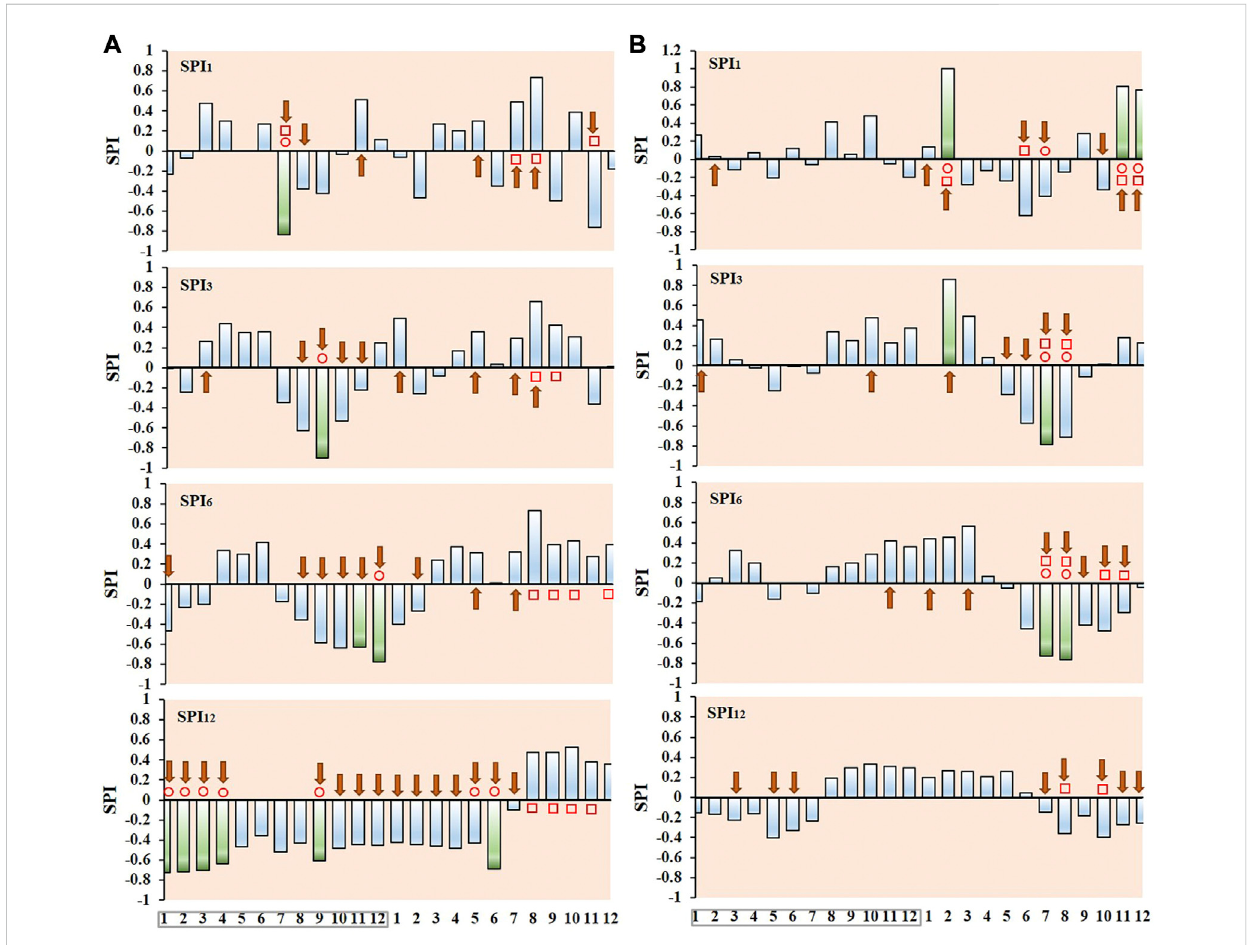
FIGURE 7 Mean SPI values at different timescales from the SPI series in the Weihe River basin. (A) El Niño and (B) La Niña years (boxed)and the year after these events. Green columns, signi fi cant differences in SPI values between El Niño/La Niña and the remaining years; blue columns, no signi fi cant difference; square, signi fi cant differences inSPI values betweenEl Niñoand La Niña years; circles, signi fi cant differences in SPI valuesbetweenEl Niño/LaNiña years and normal years; arrows, months with consistent anomalies among events [ > 70% of events have the same sign as the mean SPI (Vicente-Serrano,